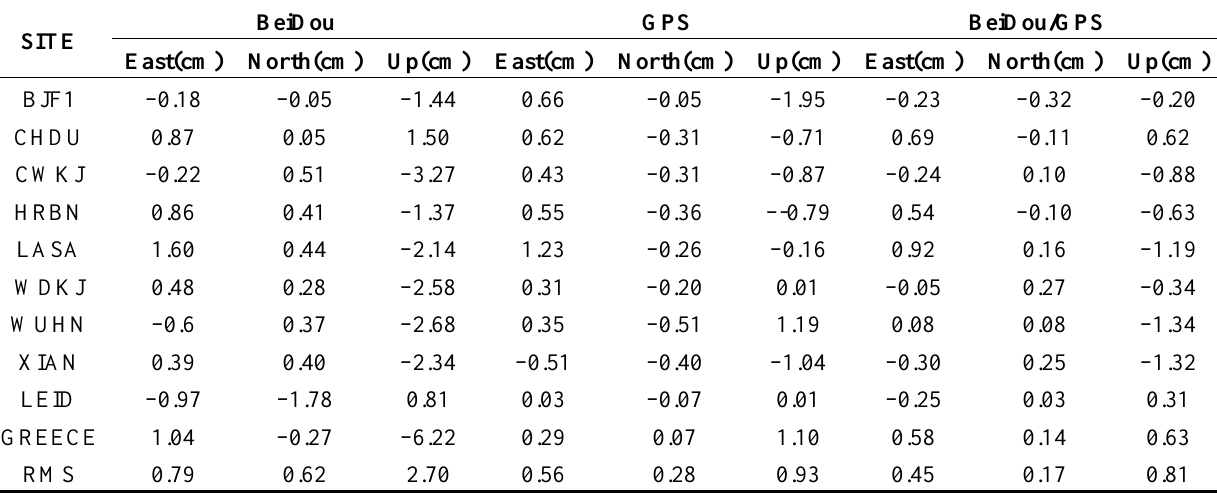
Table 2. Biases of the results of the BeiDou, GPS, and BeiDou/GPS static PPP of the “BETS” against the “ground truth” in the East, North, and Up components